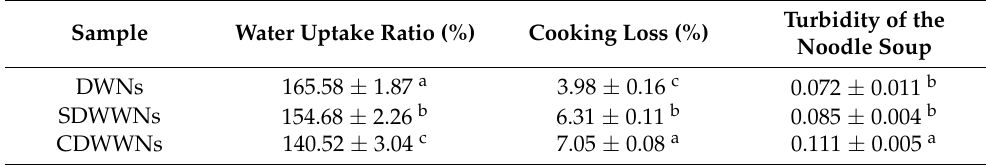
Table 1. Cooking quality of three kinds of dried